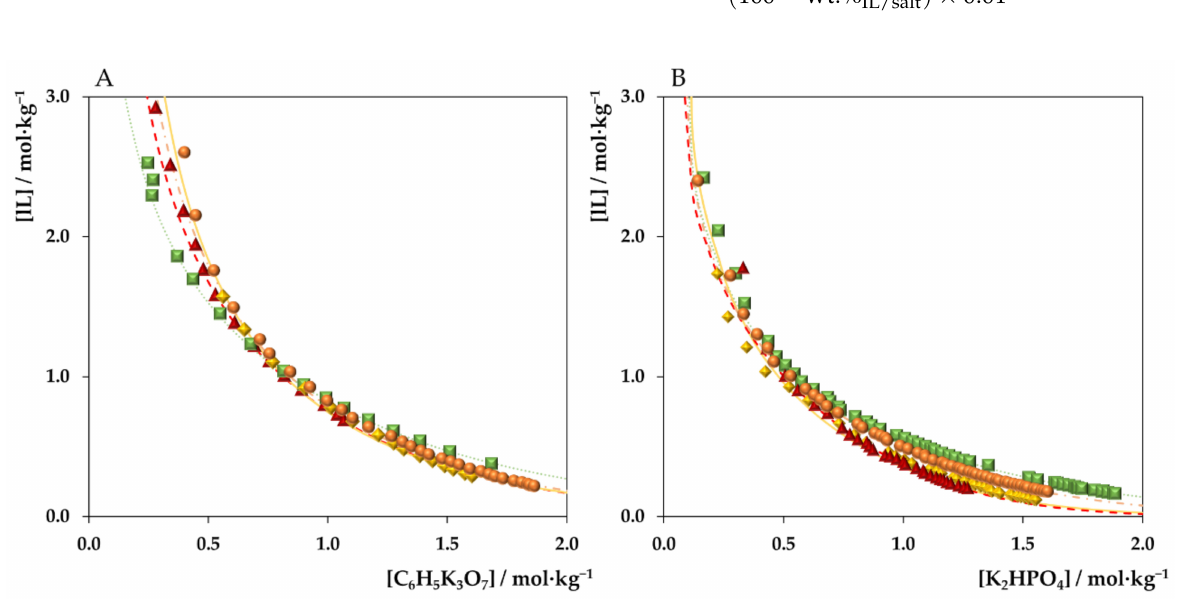
Figure 2. Binodal curves of ABSs comprising C 6 H 5 K 3 O 7 ( A ) or K 2 HPO 4 ( B ) and organic acid-derived ILs at 25 ◦ C and atmospheric pressure: [N 4444 ][CH 3 COO] ( (cid:4) ); [N 4444 ][HCOO] ( • ); [P 4444 ][CH 3 COO] ( (cid:7) ); and [P 4444 ][HCOO] ( (cid:78)